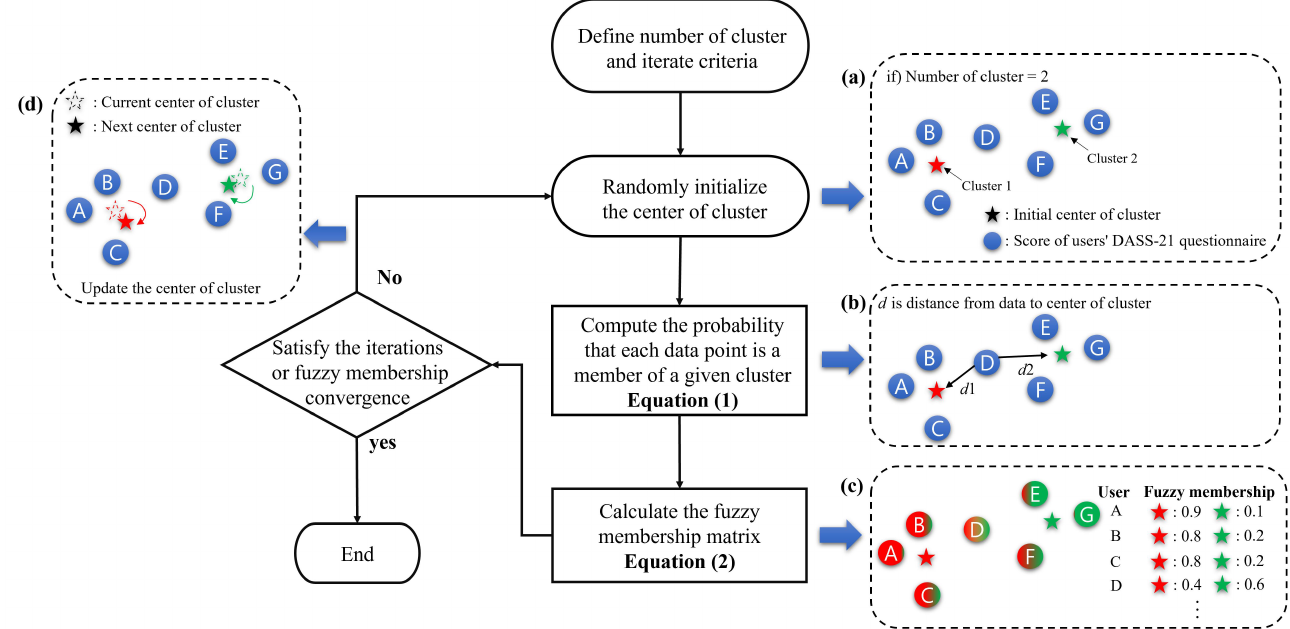
Figure 1. The process of fuzzy clustering and graphical